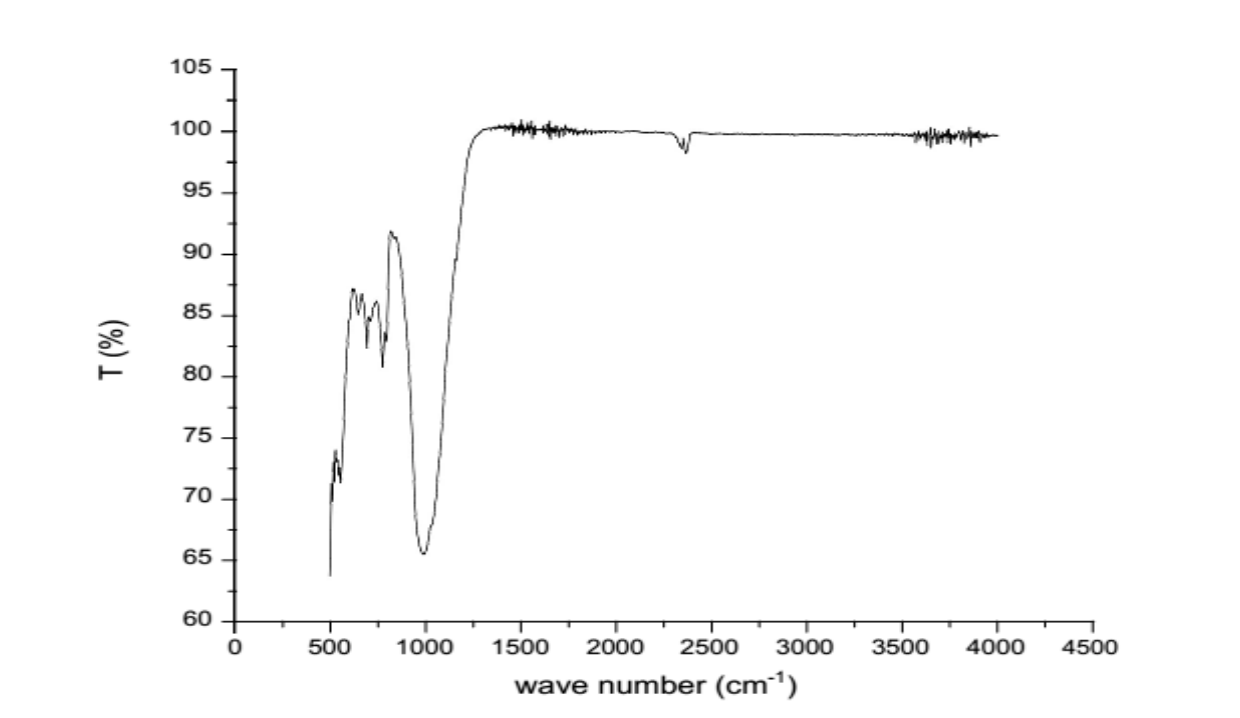
Figure 1. XRD pattern of bagasse ash.